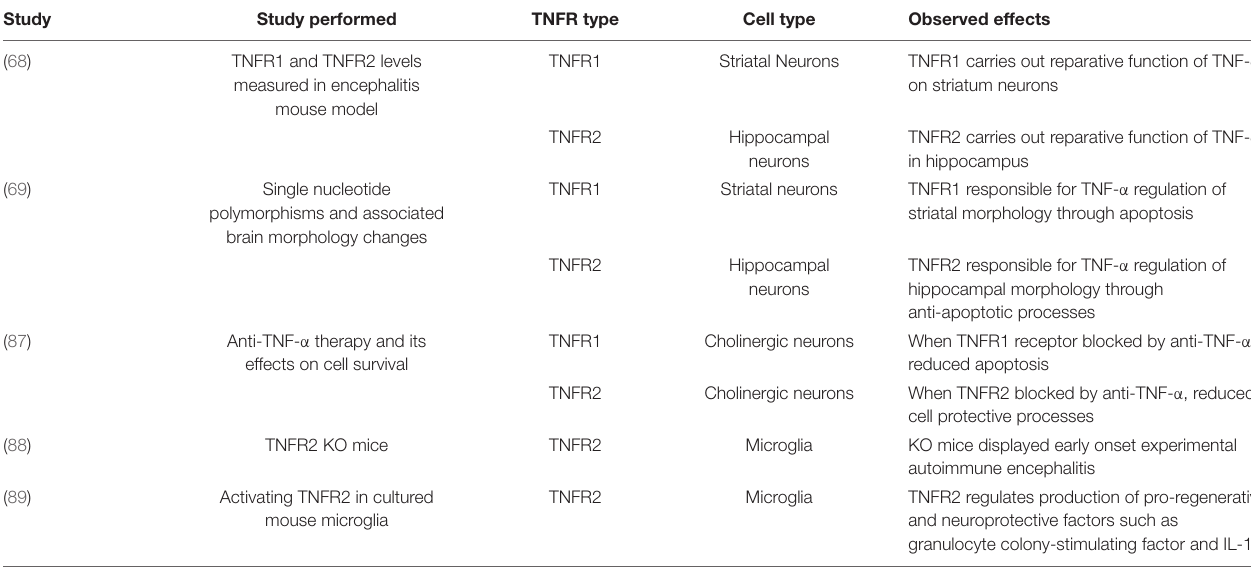
TABLE 1 | Overview of studies on TNFR1 and TNFR2’s differential processes within the brain.